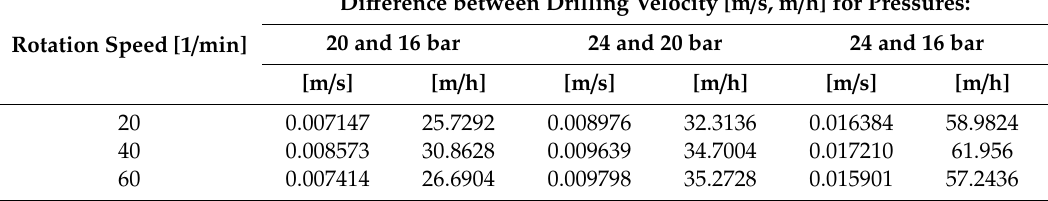
Table 6. Di ff erences between drilling velocity measured for various air pressures and drill rotation speeds of the 127 mm diameter drill bit, in the interval 90–108 m below ground